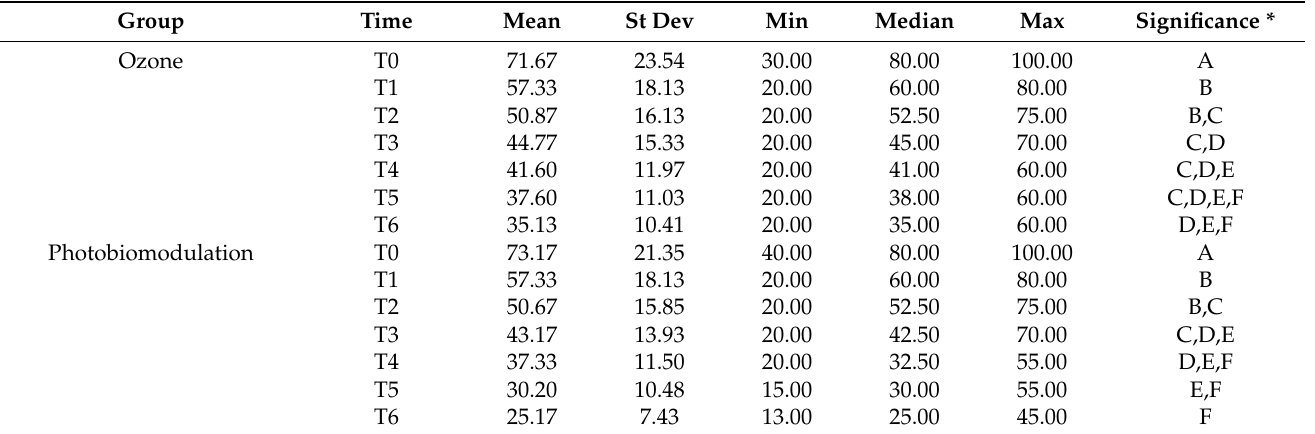
Table 4. Descriptive and inferential statistics of Plaque Index measurements